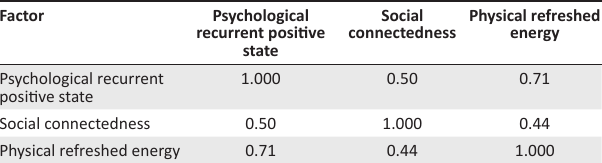
TABLE 6: Pearson Product-Moment Correlation